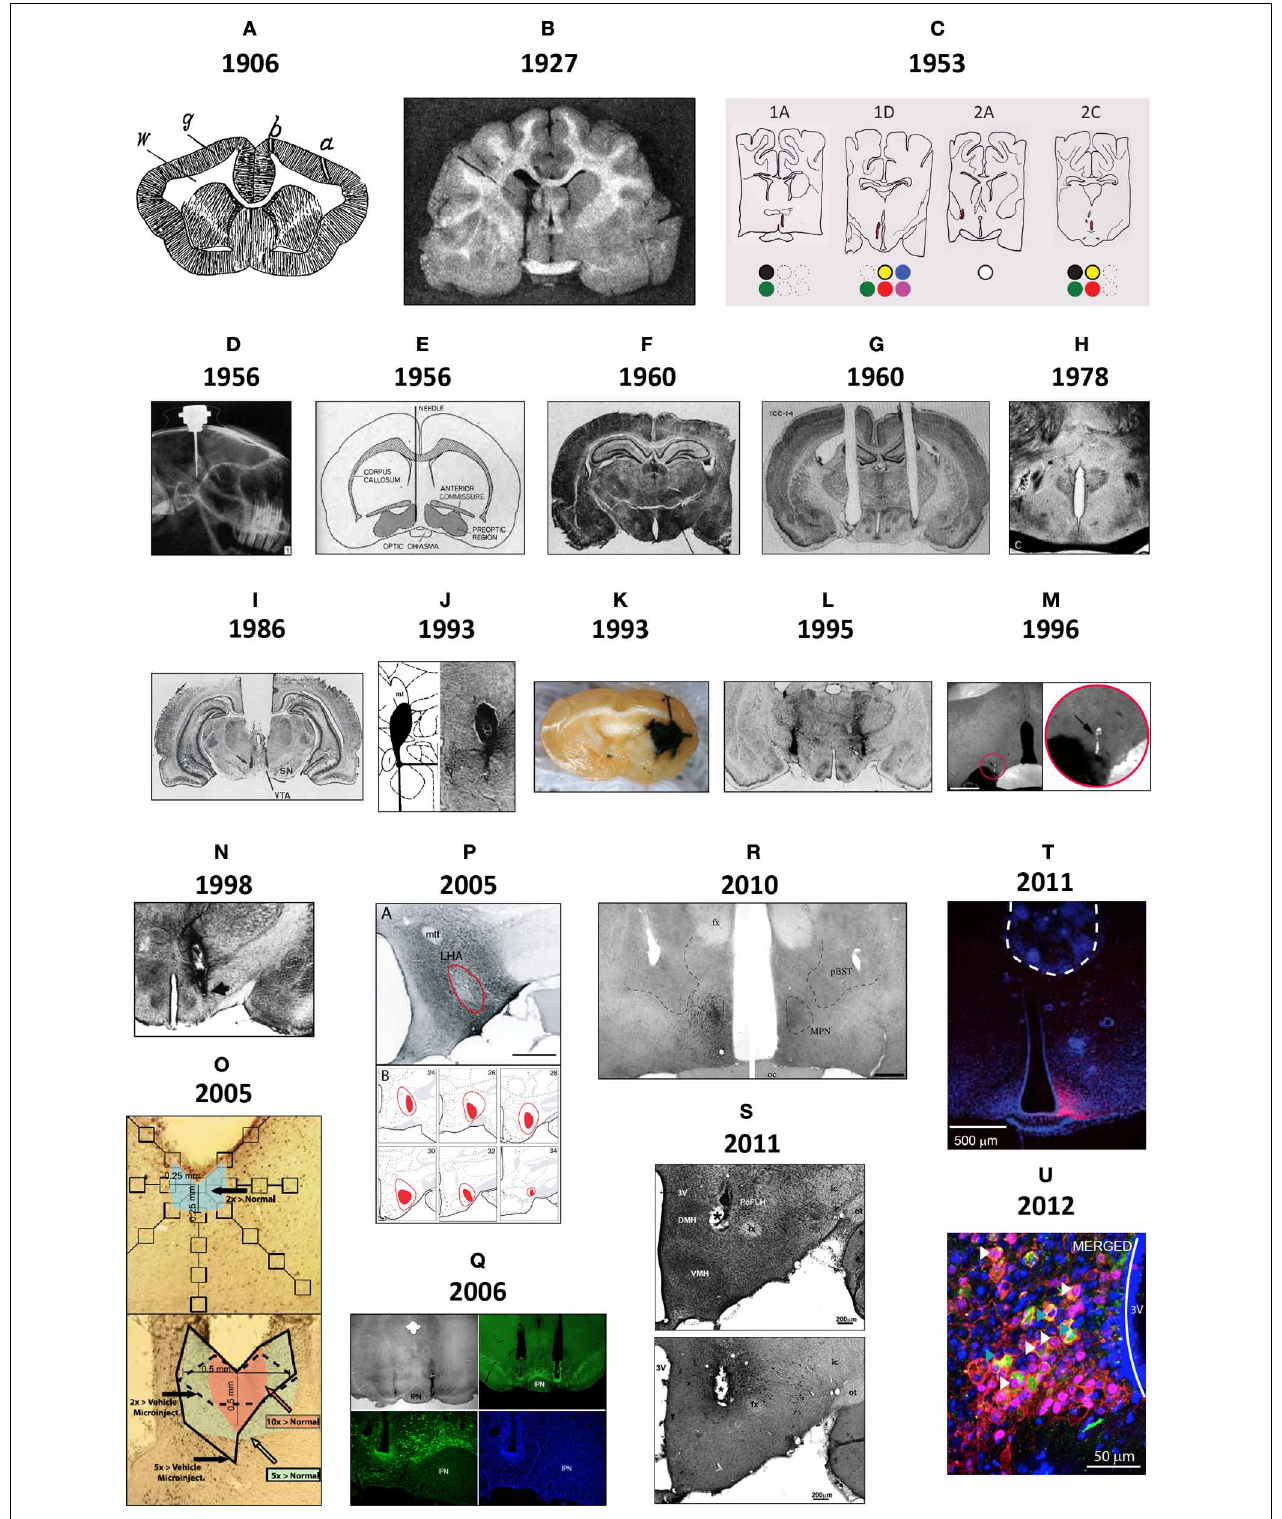
FIGURE 1 | (A) This drawing is of a frontal section from a rabbit, first published in 1906 by Samuel S. Maxwell at the University of California (Maxwell, 1906b). It shows injection sites made into the cerebral cortex, either at the superficial level of the upper gray ( g ) matter (needle track shown